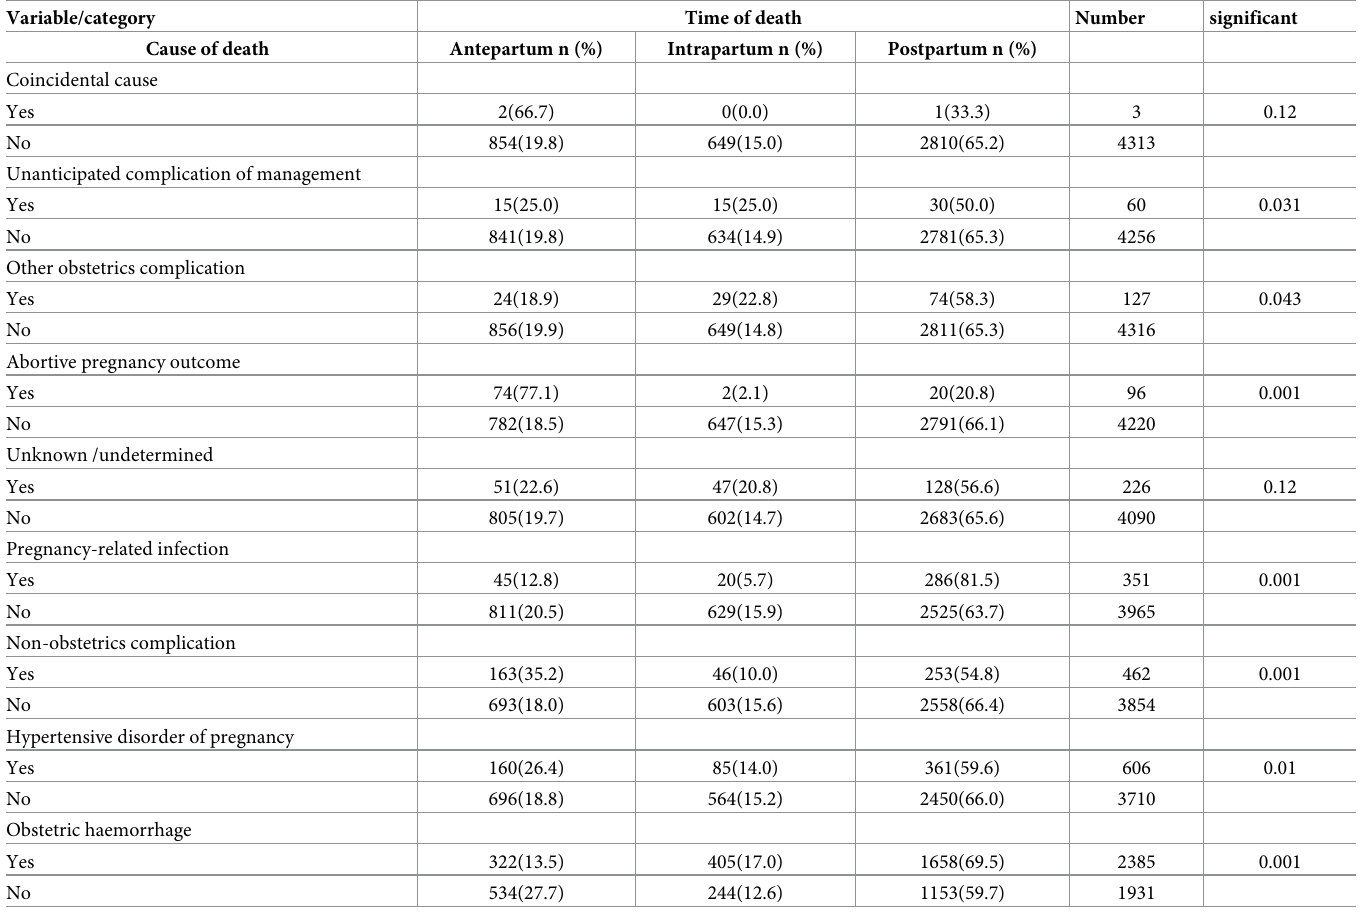
Table 3. Distribution of cause of death by time of death among reviewed maternal death in Ethiopia, 2020.